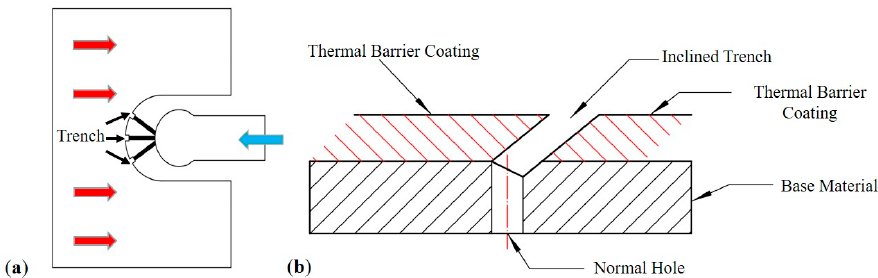
Figure 4. Schematic diagram of typical trenched film holes: ( a ) leading edge of the trenched hole; ( b ) inclined trenched hole.